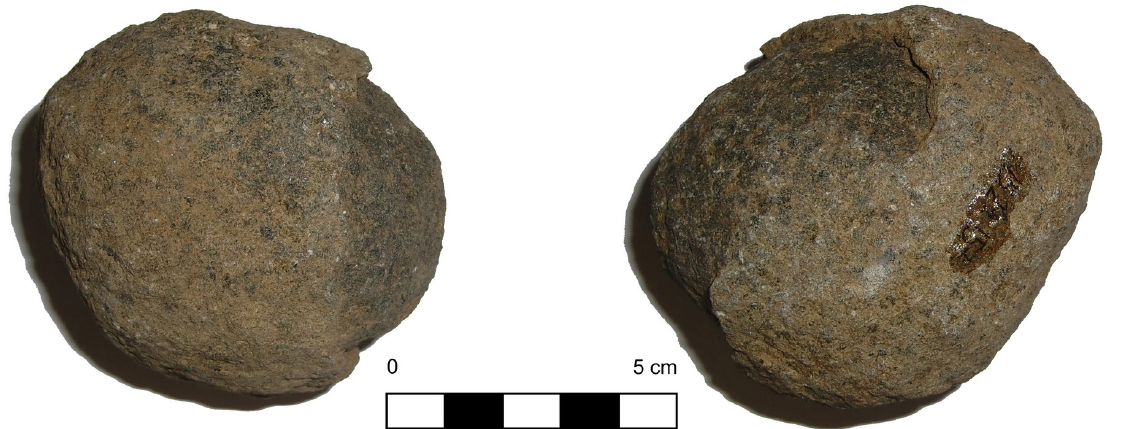
Figure 5. Pebble in ophite with blow marks found during the archaeological survey at Tozal de la Mesa area.